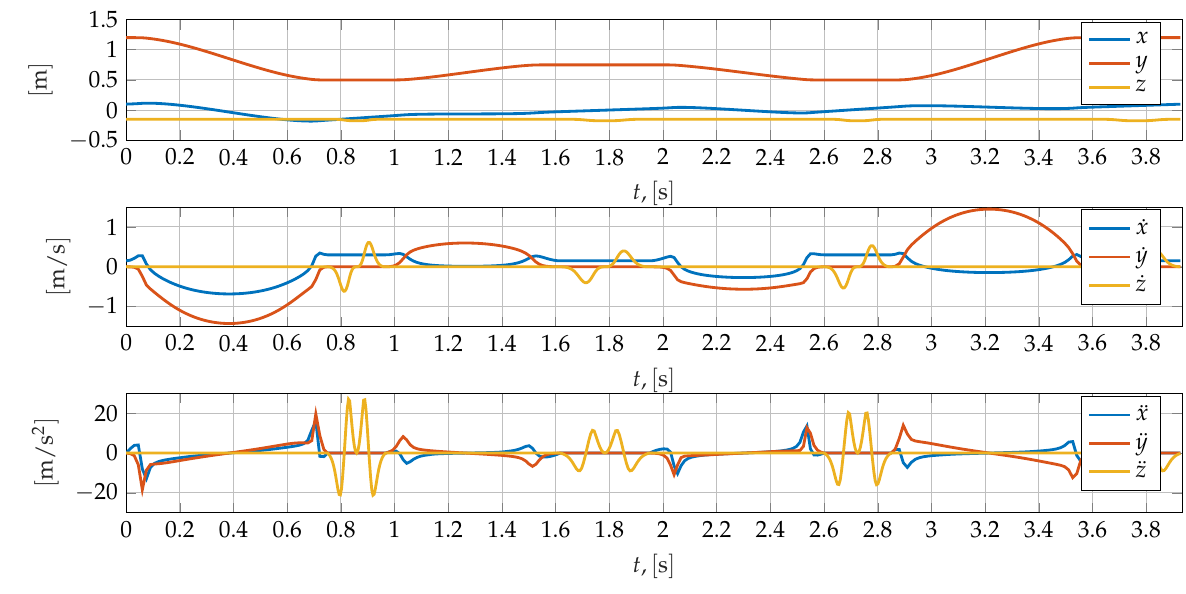
Figure 9. Position, velocity and acceleration components at the end effector.